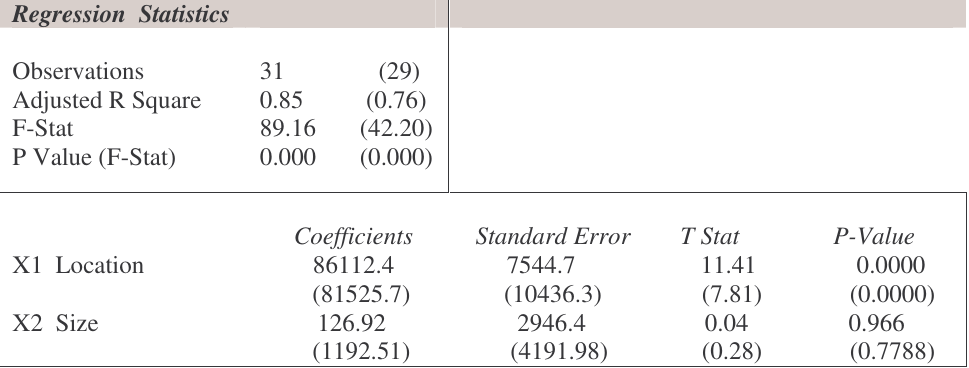
Table 3: Multiple regression 2005 (2004 in parenthesis): sales versus location and size Regression Statistics